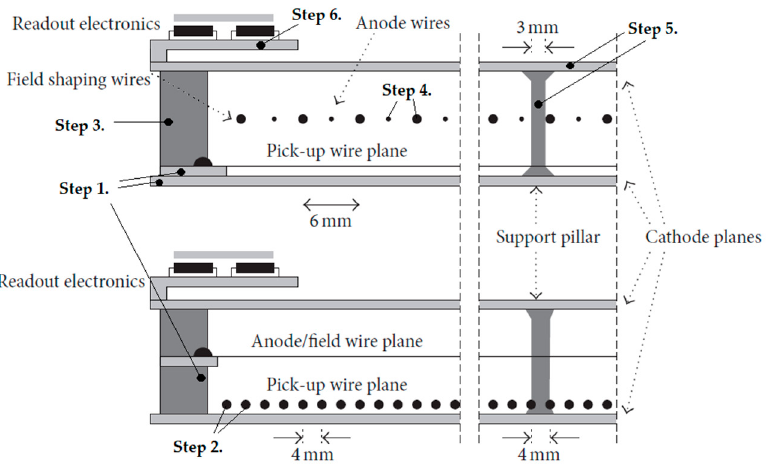
Figure 2. Cross section of the MWPC detectors. The Anode/field wire plane and the Pick-up wire plane are perpendicular to each other and the wires are fixed with soldering. The readout electronics are installed on top of the chambers with proper noise reduction shielding [10].